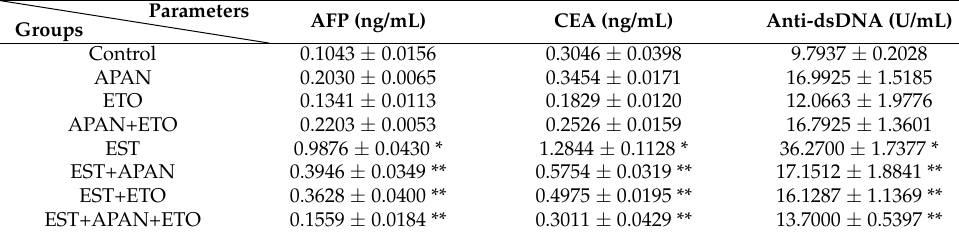
Table 4. Changes in serum tumor